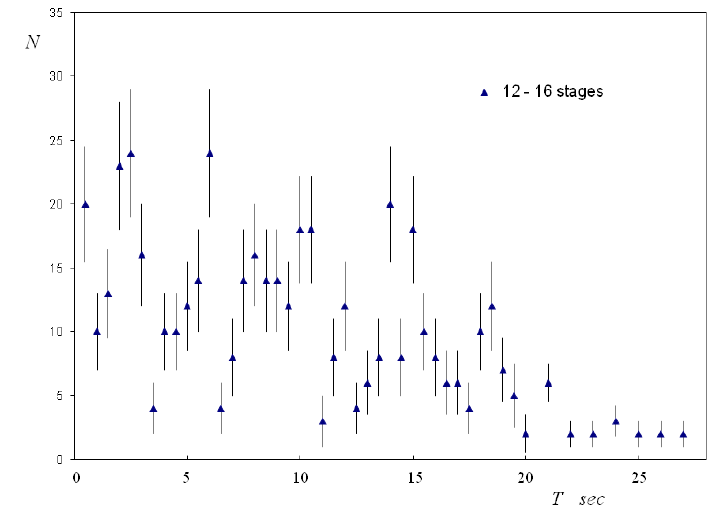
Figure 3. T distribution for fish eggs at 12 ÷ 16